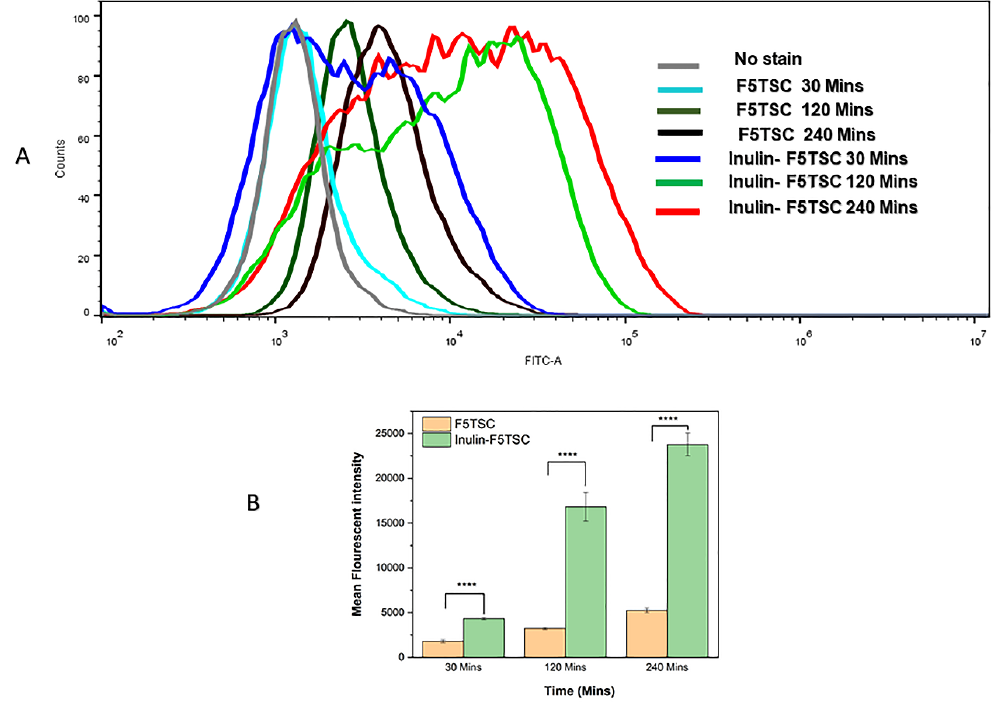
Figure 7. CLSM image of the cellular uptake of RAW264.7 macrophage cells incubated at different time points with F5TSC labeled inulin. For each panel, with the image from left to right showing cell nuclei stained by DAPI (blue), inulin-F5TSC (green) and overlays of the two images. Scale bar = 10 µ m.